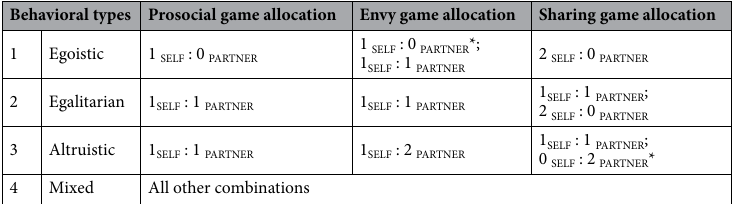
Table 2. Classification of Behavioral Types. Combinations of decisions that formed each behavioral type. * decisions that deviate from the original method.